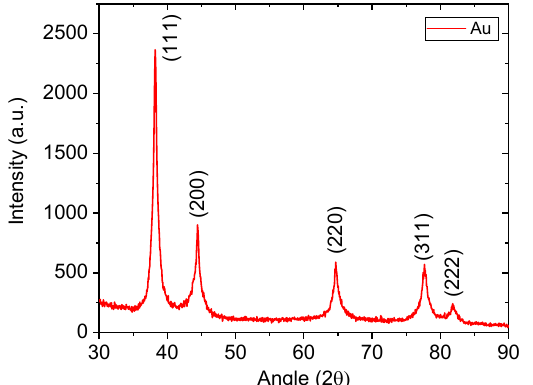
Figure 6. XRD Crystallite Size Calculator (Scherrer Equation) = 11 ± 2 nm.